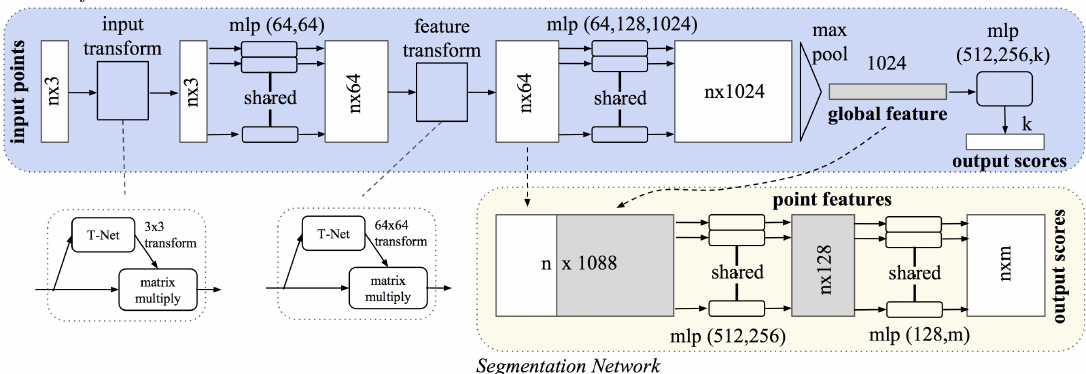
Figure 6. Architecture of PointNet [42]. PointNet is composed of multilayer perceptrons (MLPs), which are shared point-wise, and two spatial transformer networks (STN) of 3 × 3 and 64 × 64 dimensions which learn the canonical representation of the input set. The global feature is obtained with a winner-takes-all principle and can be used for classification and segmentation